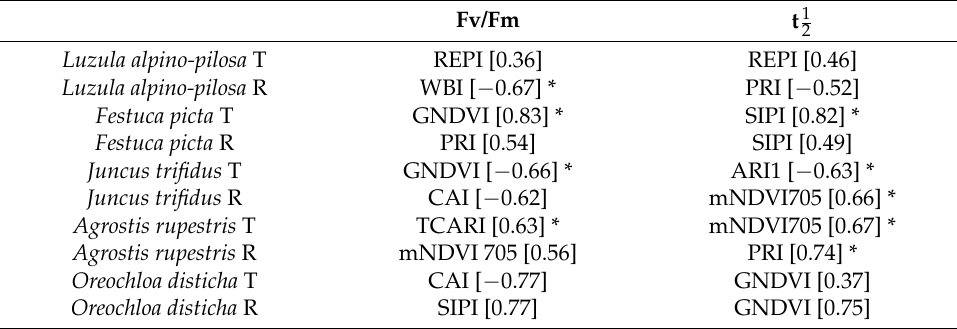
Table 6. The Spearman correlation of remote sensing vegetation indices and fluorometric indices (Fv/Fm, t 1 —with adaptation to darkness) for all species marked T (trampled) and R (reference); 2 *, statistical significance at the 0.05